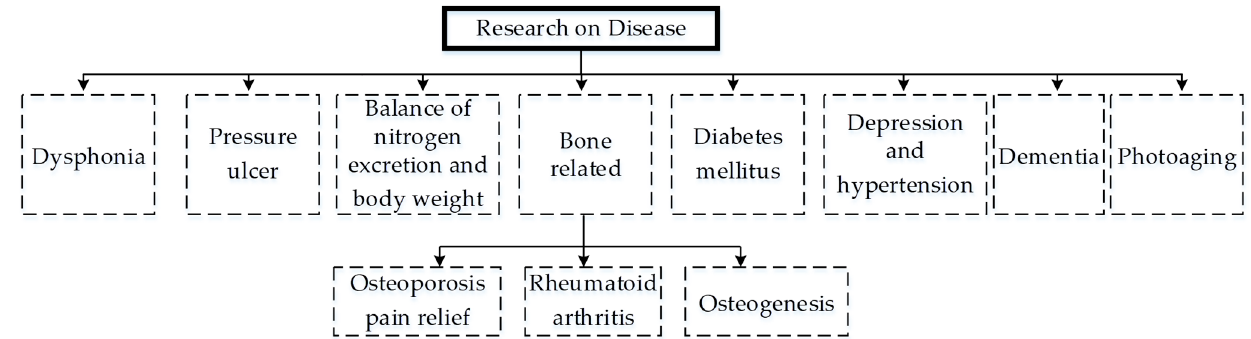
Figure 6. Hierarchical breakdown for research on disease (the dark rectangle shows the level 1, and the dotted rectangles are showing subcategory).